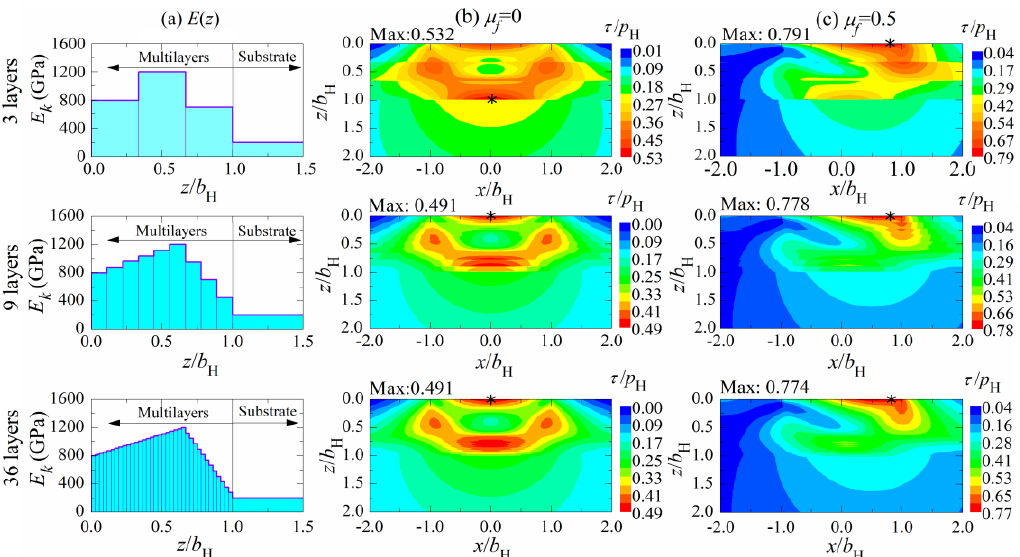
Figure 7. Contour plots of the maximum shear stress in the subsurface of multilayered solids with a similar structure layout but a different layer number, ( a ) the elasticity modulus along z axis, ( b ) the maximum shear stress when μ f is 0, ( c ) the maximum shear stress when μ f is 0.5.